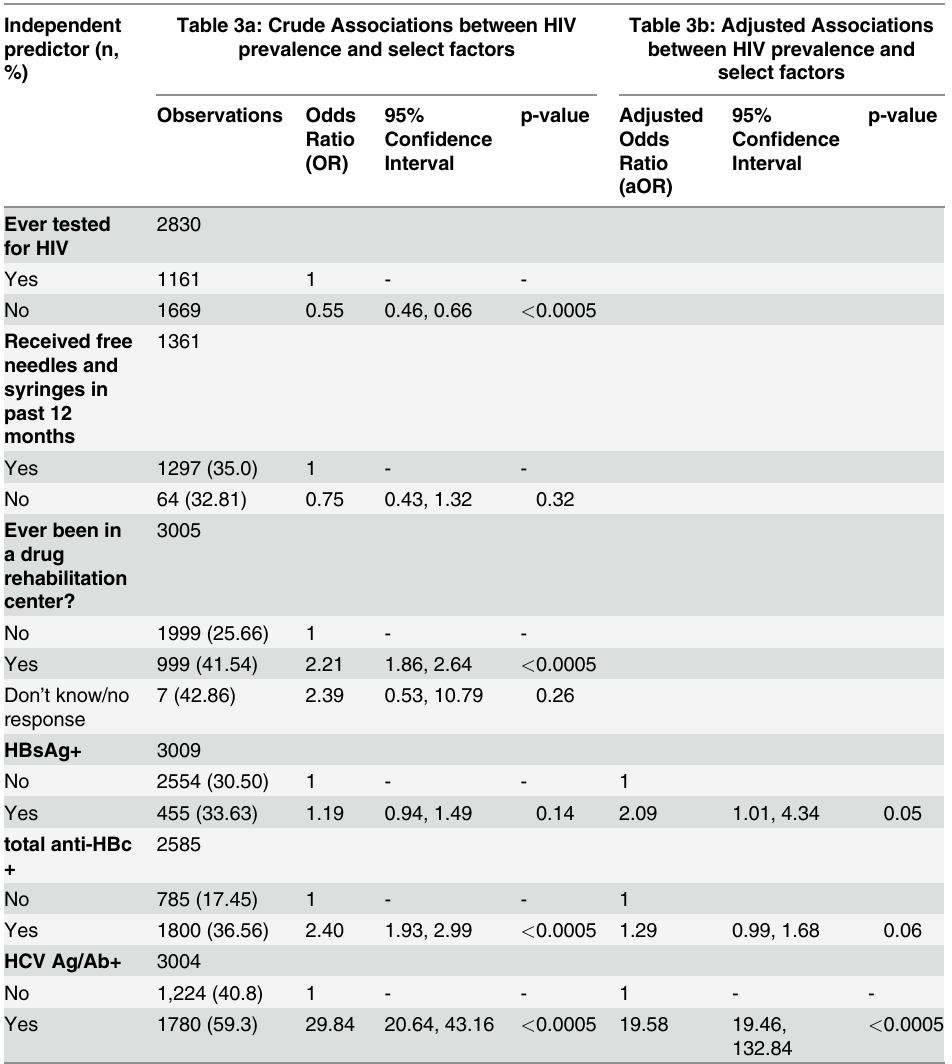
Table 3b: Adjusted Associations between HIV prevalence and select